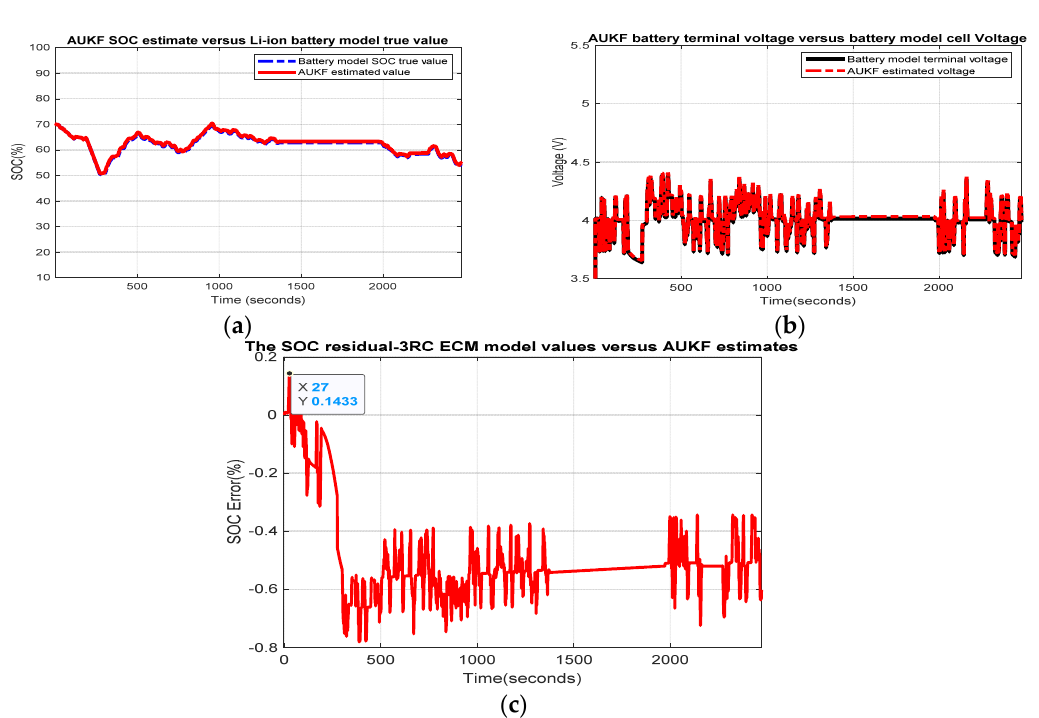
Figure A18. The MATLAB simulation results for Simulink 3RC ECM Li-ion battery. ( a ) The AUKF SOC value versus battery model SOC true value; ( b ) The AUKF terminal output voltage versus battery model terminal output voltage true value; ( c ) The SOC residual.